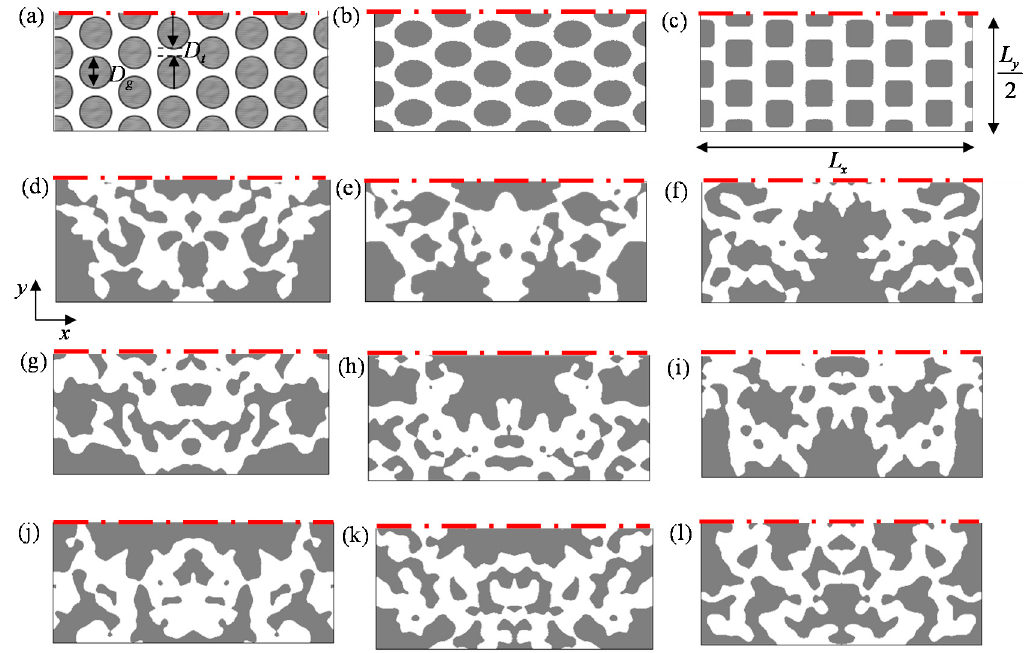
Figure 1. Regular elementary cells ( a ) HDa, ( b ) HDb, ( c ) HDc and randomly generated elementary cells ( d ) E1, ( e ) E2, ( f ) E3, ( g ) E4, ( h ) E5, ( i ) E6, ( j ) E7, ( k ) E8, and ( l ) E9. Gray and white regions respectively correspond to the solid matrix and to the pore space. Horizontal dashed-dotted lines indicate axes of symmetry of the systems. L x : size of the medium along x -; L y : size of the medium along y -; D g : grain diameter; D t : throat diameter.